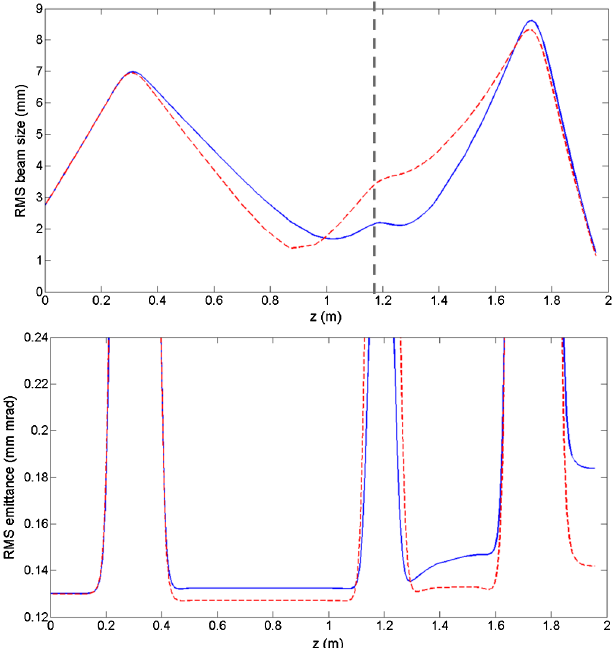
FIG. 5. Top: Beam envelopes simulated with T RACE W IN start- ing with a beam distribution with uniform current density (dashed, red) and a Gaussian current density distribution (solid, blue). The dashed vertical line indicates the transition from neutralized to un- neutralized transport. Bottom: Corresponding emittance evolu- tion. Apparent jumps of the emittance inside the solenoids are related to the specific way of emittance calculation by T RACE W IN